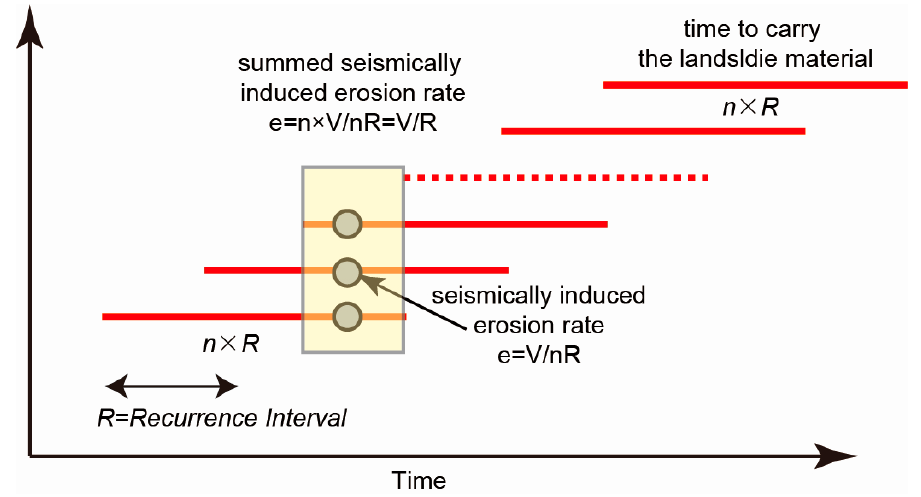
Figure 2. Simplified comparison of erosion rates according to the residence time of the co-seismic landslide material.